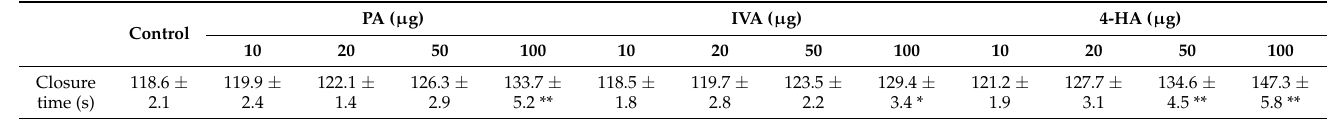
Table 5. PFA-100 assay of PA, IVA, and 4-HA using collagen/epinephrine